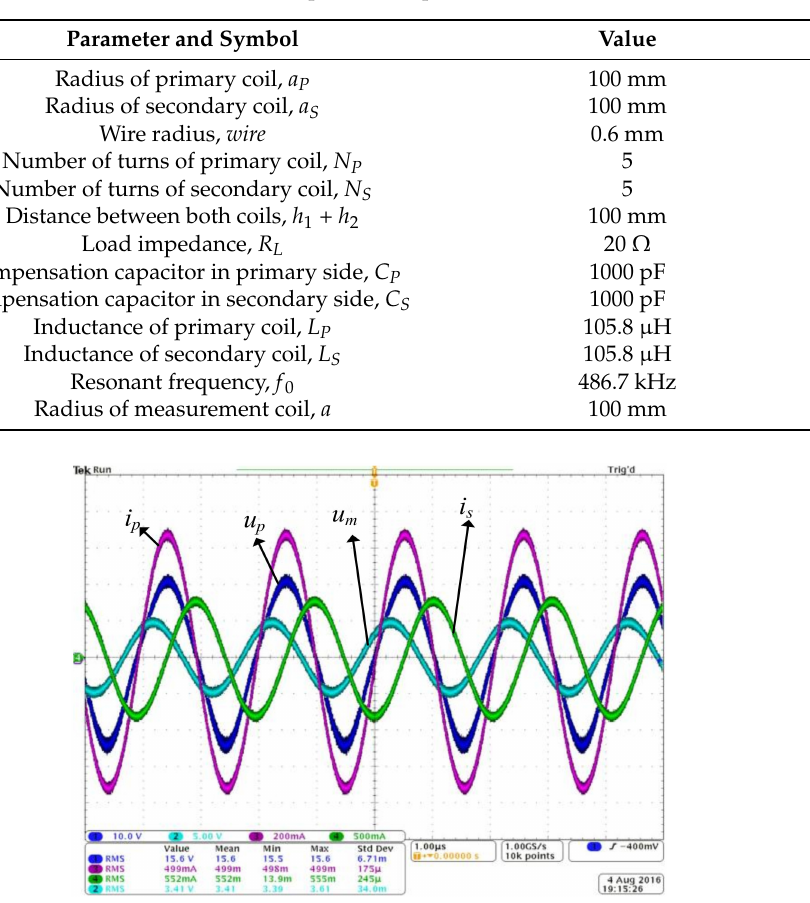
Figure 13. Waveforms of primary voltage u p , primary current i p , secondary current i s and induced voltage u m of the measurement coil.